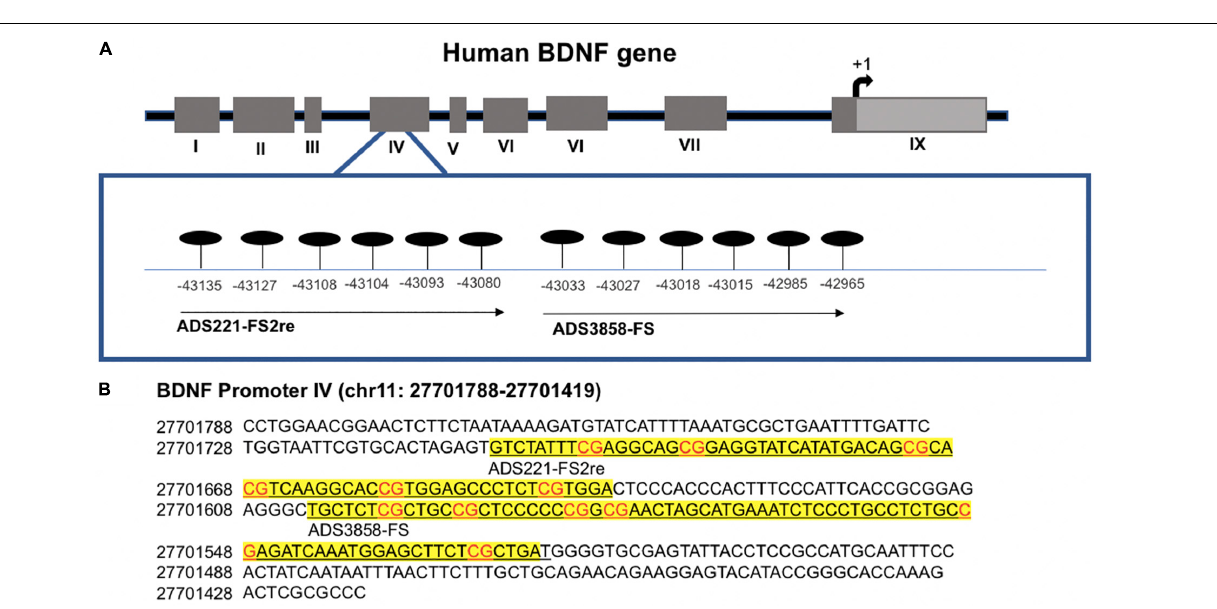
HD patients and n = 18 normal controls ( Table 1 )